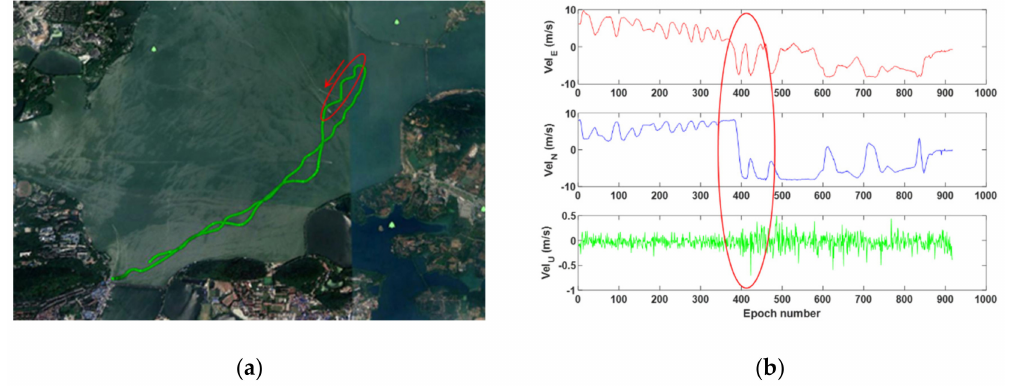
Figure 4. Ship’s trajectory ( a ) and reference velocity ( b